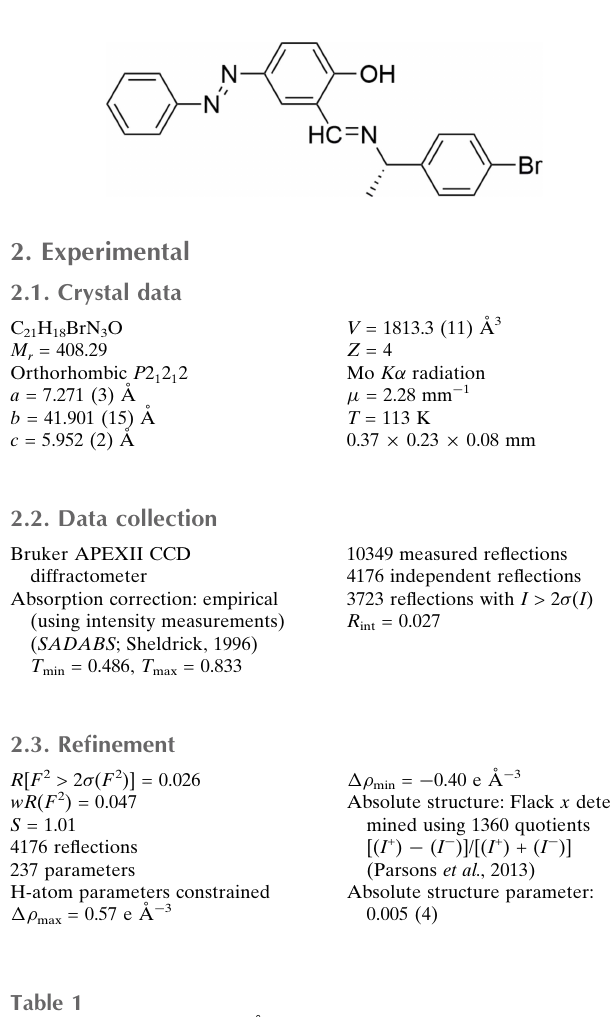
Hydrogen-bond geometry (A˚ , (cid:5)